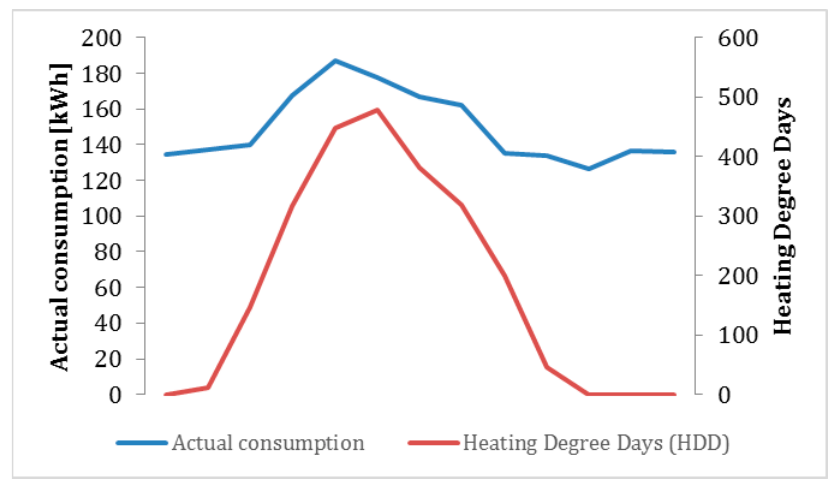
Figure 5. Actual consumption and heating degree days for the period examined.